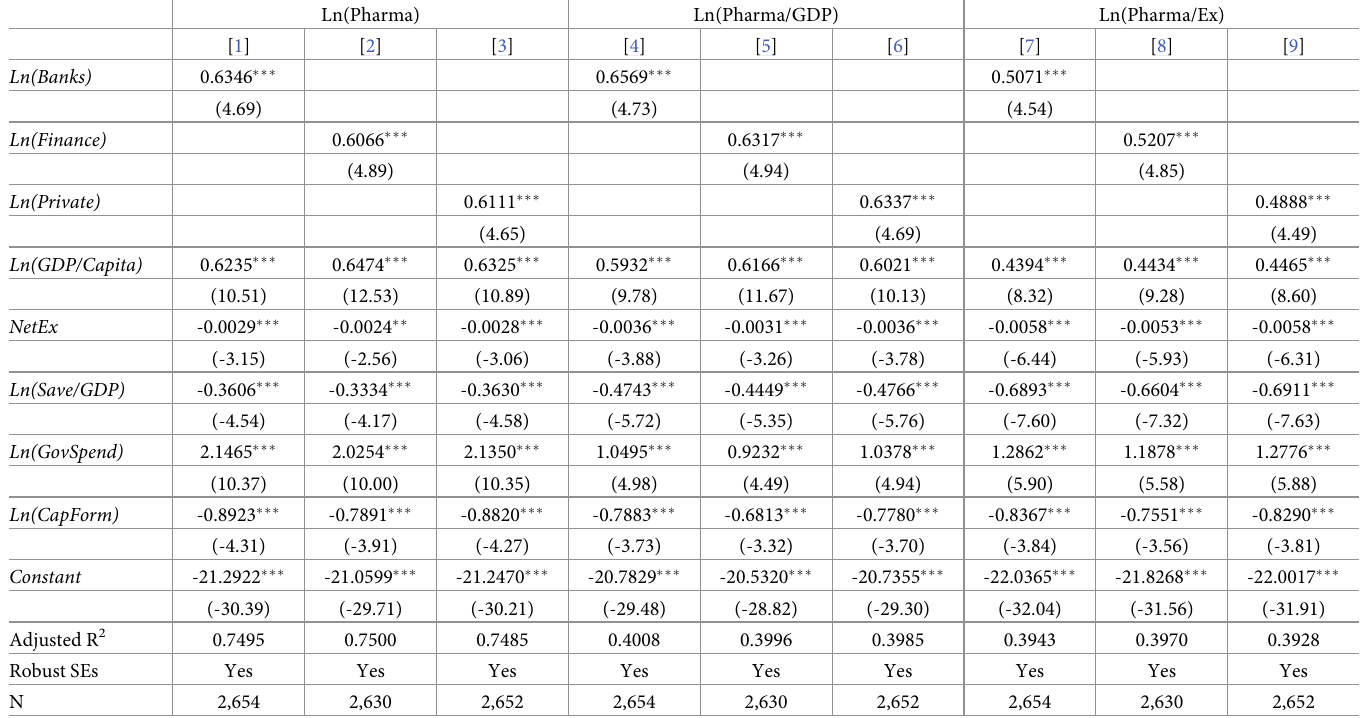
Table 3. Pharmaceutical innovation and credit market